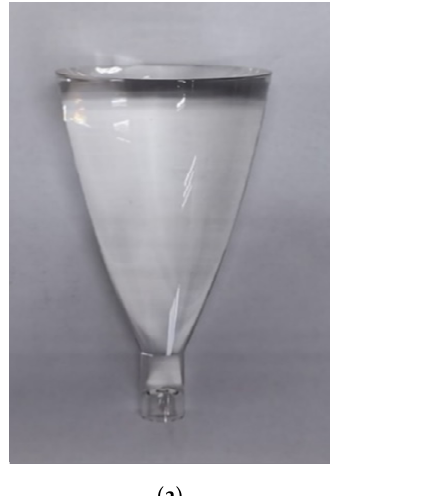
Figure 1. ( a ) Receiving unit with a convex outlet concentrator. ( b ) Receiving unit with a concave outlet concentrator.